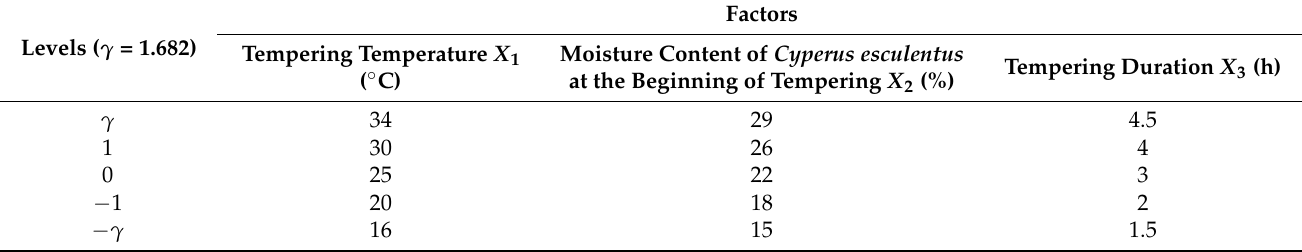
Table 3. Experimental factors and levels coding of multi-factor